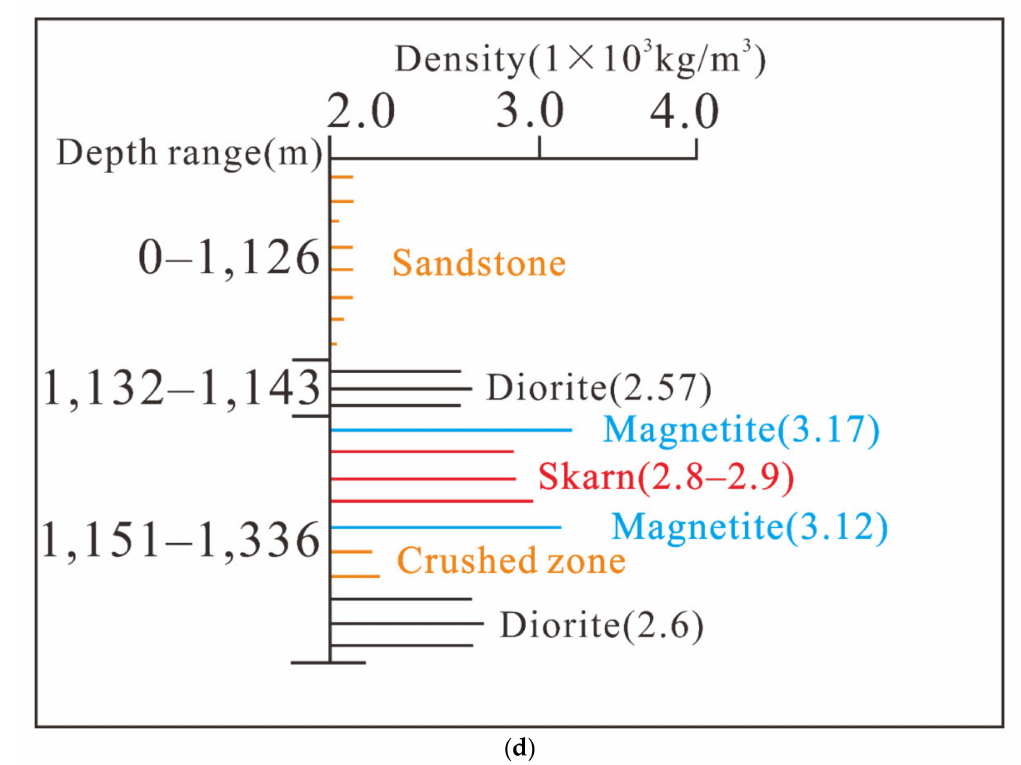
Figure 12. Real data. ( a ) Geological map of Liaoning western area. ( b ) Real airborne gravity anomaly of Liaoning western area. ( c ) Calculated airborne gravity vertical gradient anomaly of Liaoning western area. ( d ) Drilling data